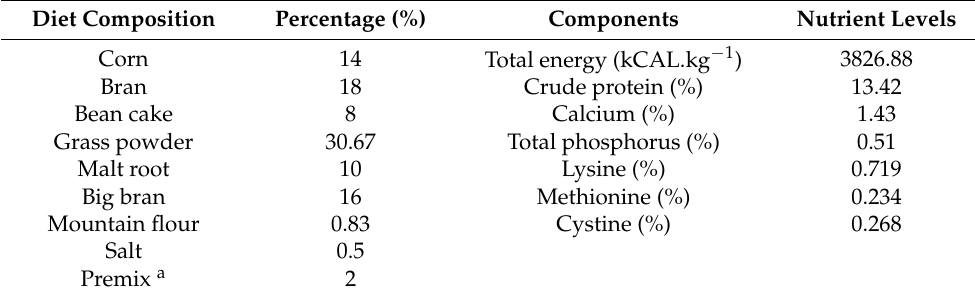
Table 2. Composition and nutrient levels of the basal diet. Diet